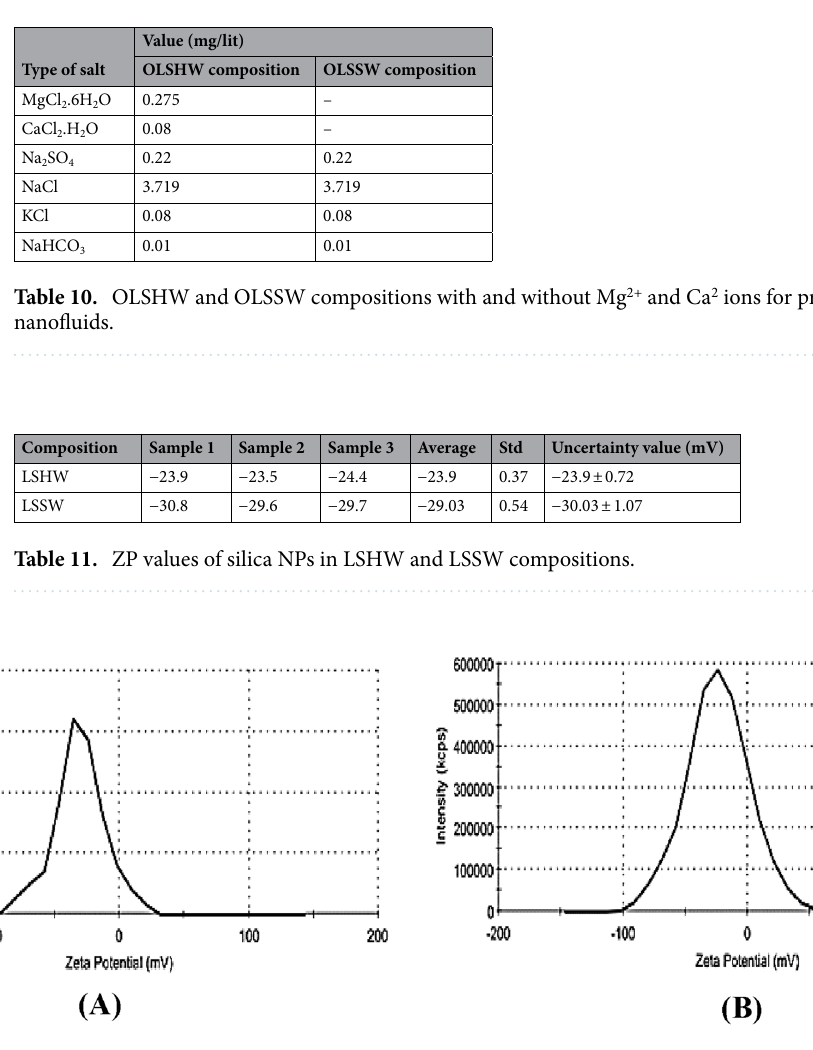
Figure 4. ( A ) More stability of NPs in LSSW without calcium and magnesium ions (ZP = −30.8), ( B ) lower stability of NPs in LSHW with calcium and magnesium ions (ZP =